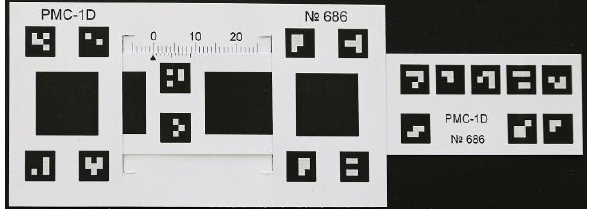
Figure 1. The marker PMC-1D for one-dimensional monitoring.